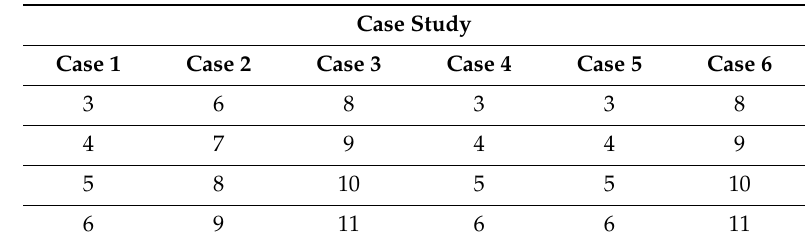
Table 4. Candidate buses (70% threshold values).